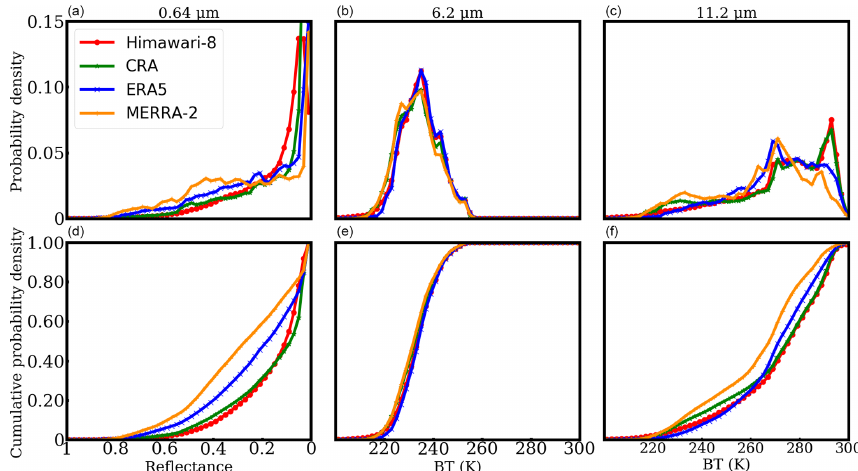
Figure 6. Probability and cumulative probability density for the observed and simulated reflectances in the 0.64µm channel (a, d) and for the BTs in the 6.2µm (b, e) and 11.2µm (c, f)